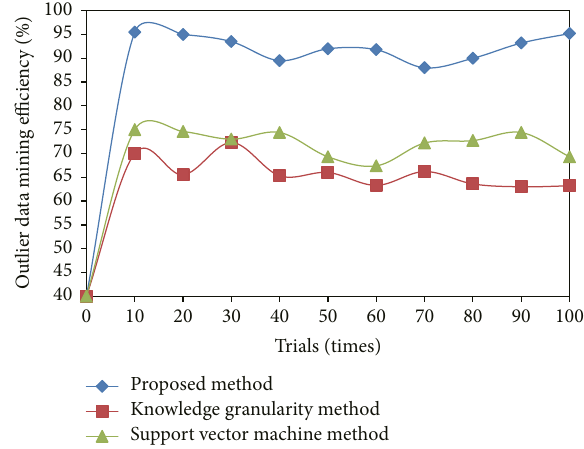
Figure 13: Comparison of outlier data mining accuracy.